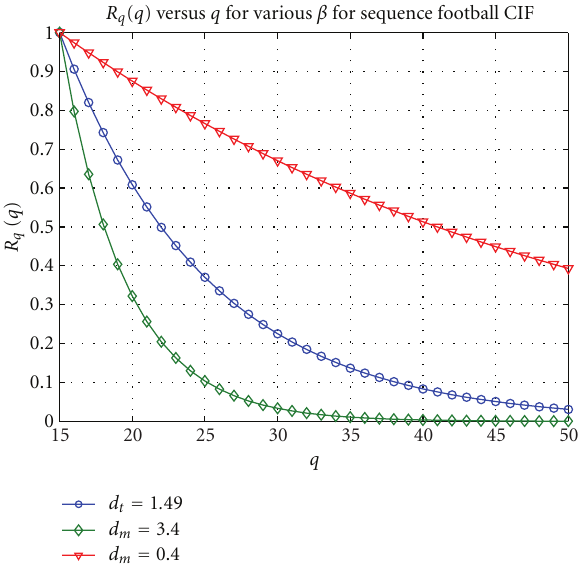
Figure 14: Quality versus quantization parameter at various β for sequence football CIF: β t = true value, β m = misreprted